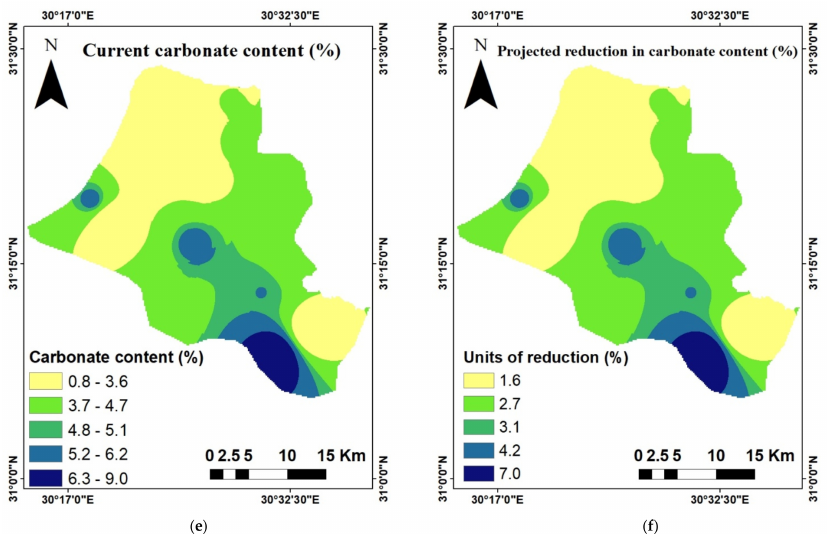
Figure 9. Spatial distribution of soil factors under CS and their projected reduction units under OS: soil salinity ( a , b ), sodium saturation ( c , d ), and carbonate content ( e , f ).